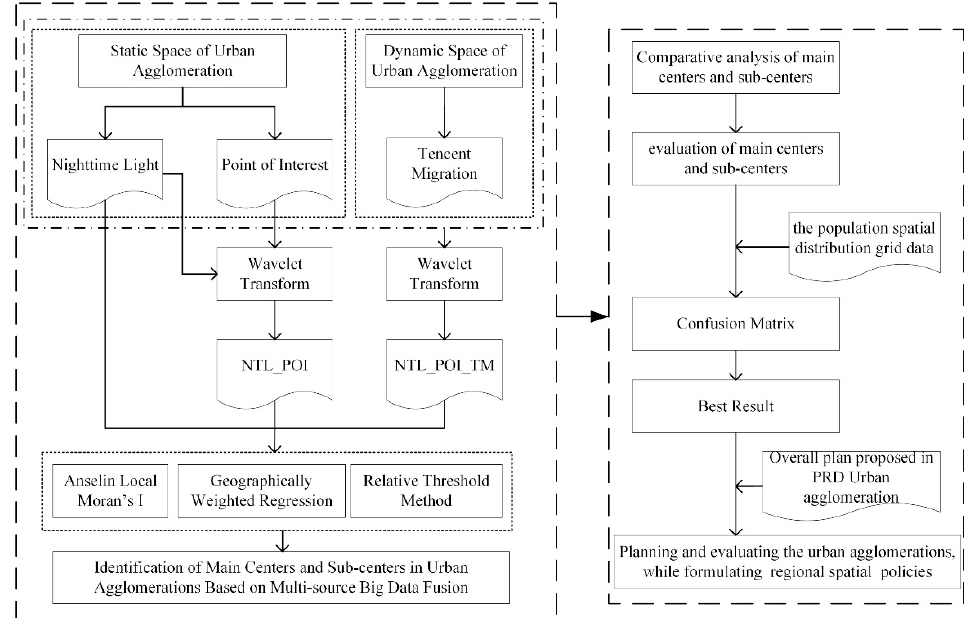
Figure 6. Structure analysis diagram.